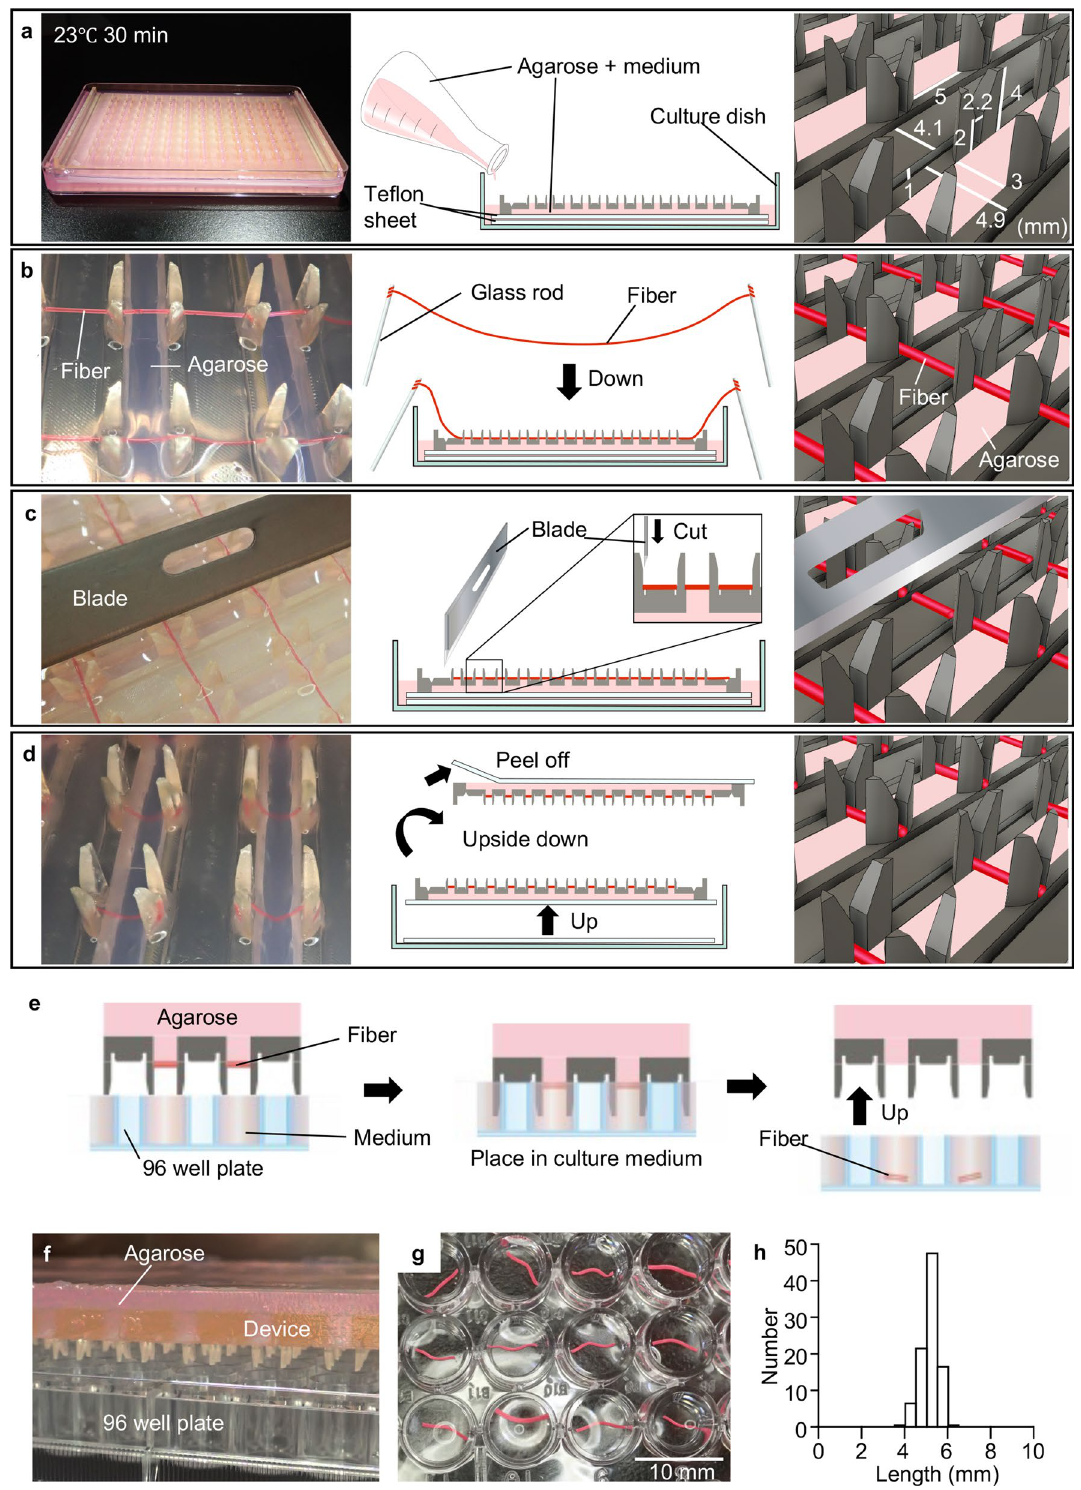
Figure 2. Formation of an array of the CF fragments on a 96-well plate. ( a ) Photograph of the fabricated device (left), illustration of device fabrication (center), and enlarged illustration of the device (right). ( b ) Photograph of the fiber installation on the device (left), illustration of the fiber installation on the device (center), and enlarged illustration (right). ( c ) Photograph of the cutting fibers on the device with a blade (left), illustration of the cutting fibers on the device with a blade (center), and enlarged illustration (right). ( d ) Photograph (left), illustration (center), and enlarged illustration (right) of the device with the fibers removed from the square dish. ( e ) Illustration of the transfer of the fibers from the device to a 96-well plate, ( f ) side view of the transfer of the device to a 96-well plate. ( g ) Photograph of the fibers transferred to a 96-well plate, and ( h ) graph showing the measured length of the fibers in a 96-well plate array. The length of the fiber was 5.18 ± 0.45 mm (mean ± SD, n =